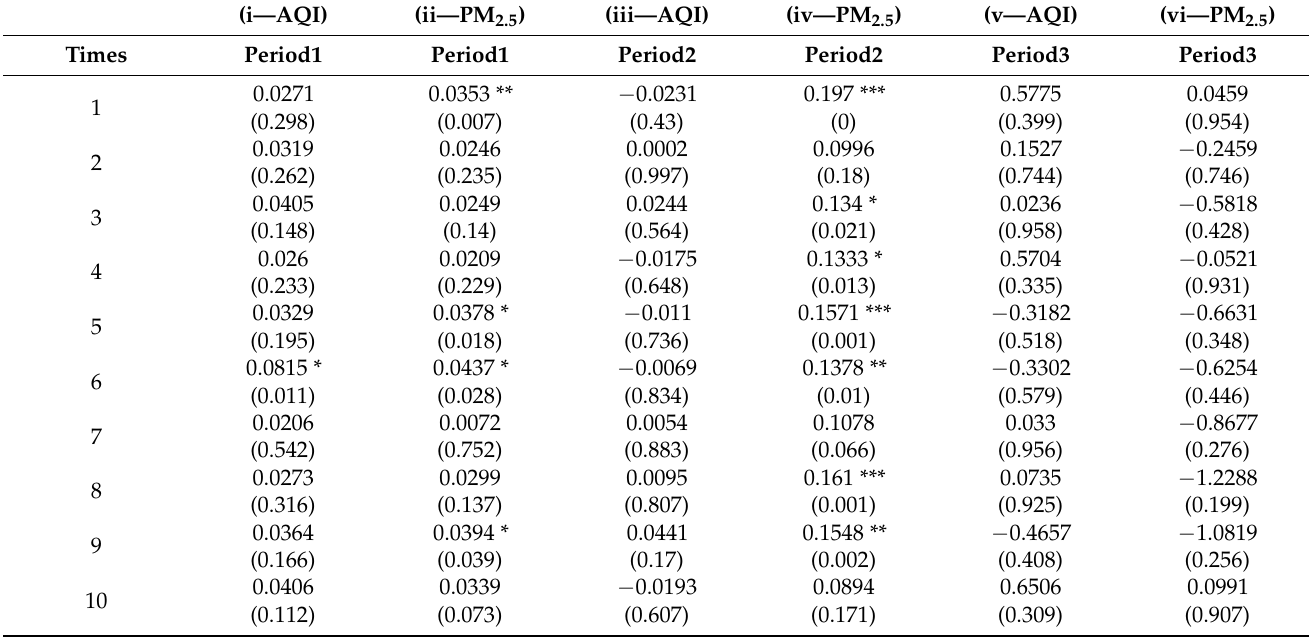
Table A10. Ten times of the effect’s estimation of air pollution on people’s activity on the randomly sampled on the bus stop POIs.